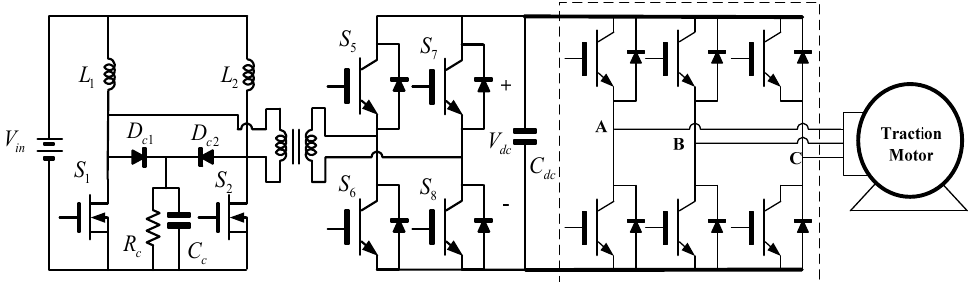
Figure 7. Bidirectional DC–DC converter with a current doubler for LV side and full–bridge voltage source converter for HV side [7].